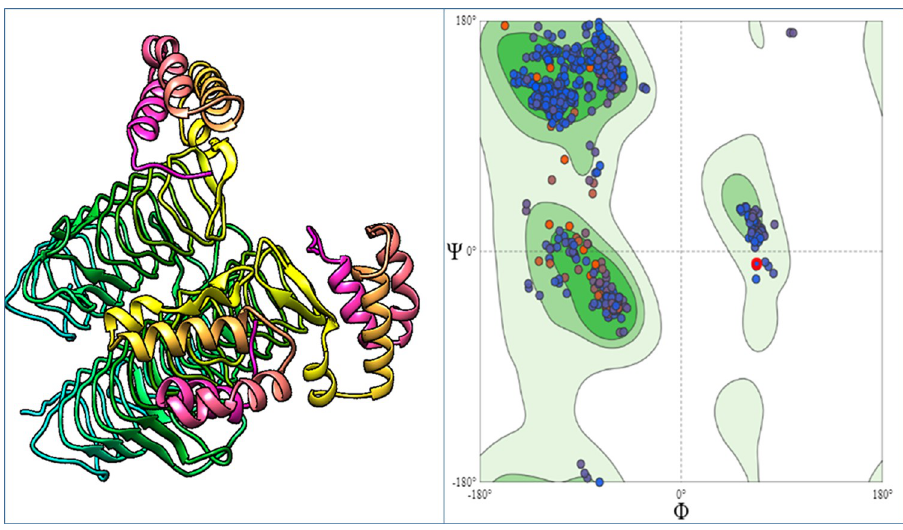
Fig 3. Structure of the D-alanine-D-alanine ligase protein. (A) Three dimensional structure of D-alanine-D-alanine ligase protein. (B) Ramachandran Plot of D-alanine-D-alanine ligase protein.